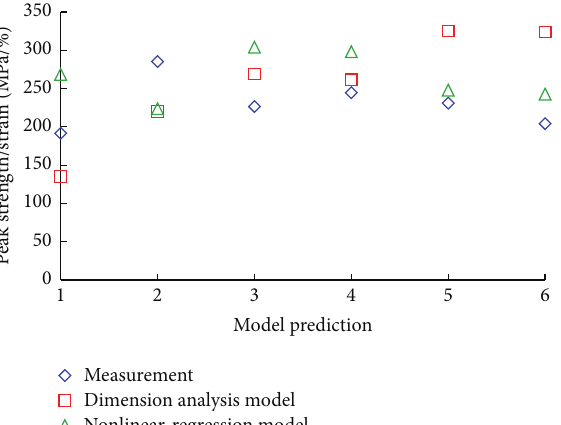
Figure 12: Predictions of multi-nonlinear-regression and dimension analysis models (using the data in Figure 8(a) for training and the rest of the data for validation; the relative average error of the dimension analysis model is 22.04% and the relative average error of the multi- nonlinear-regression model is